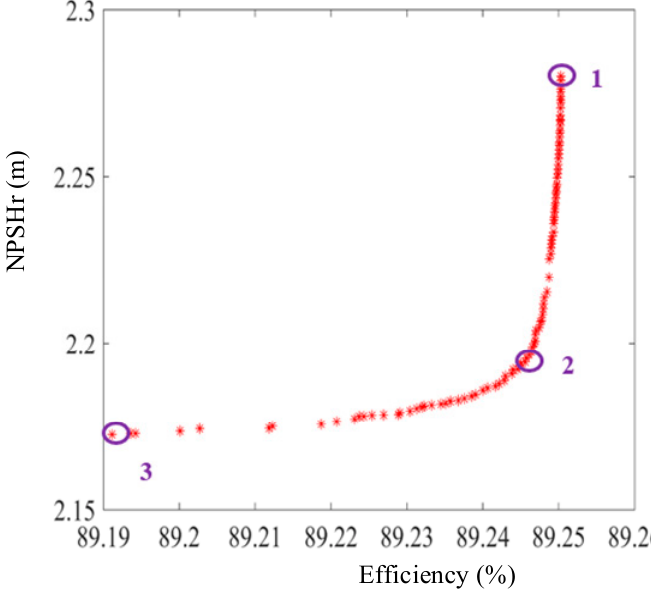
Figure 14. Validation of ANN prediction with CFD.